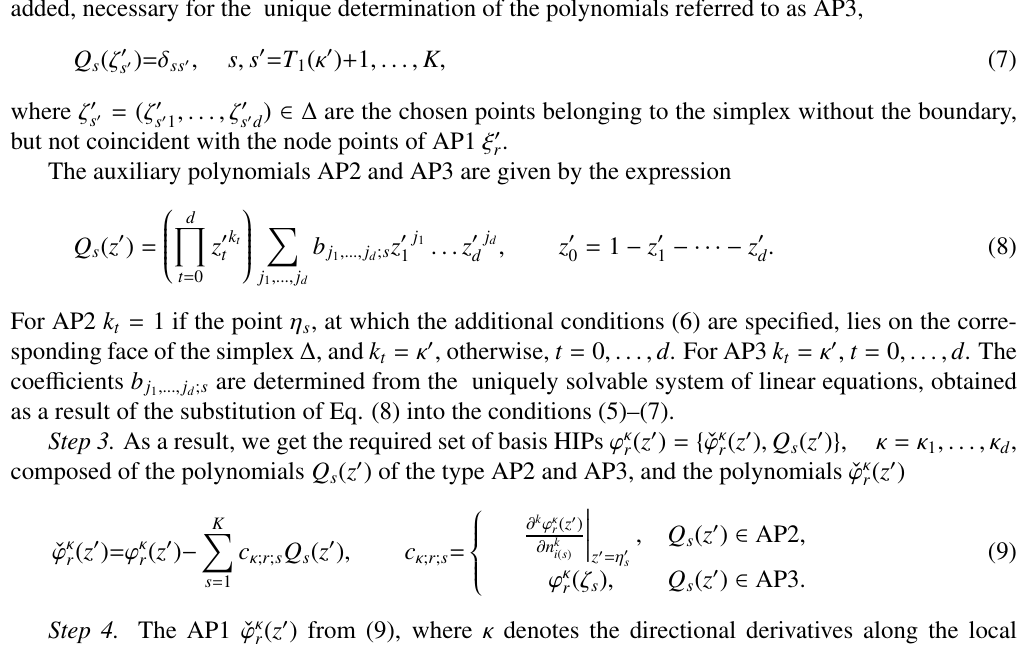
( z (cid:31) ) specified in the local coordinates, but now r , j = 1 , 2 j